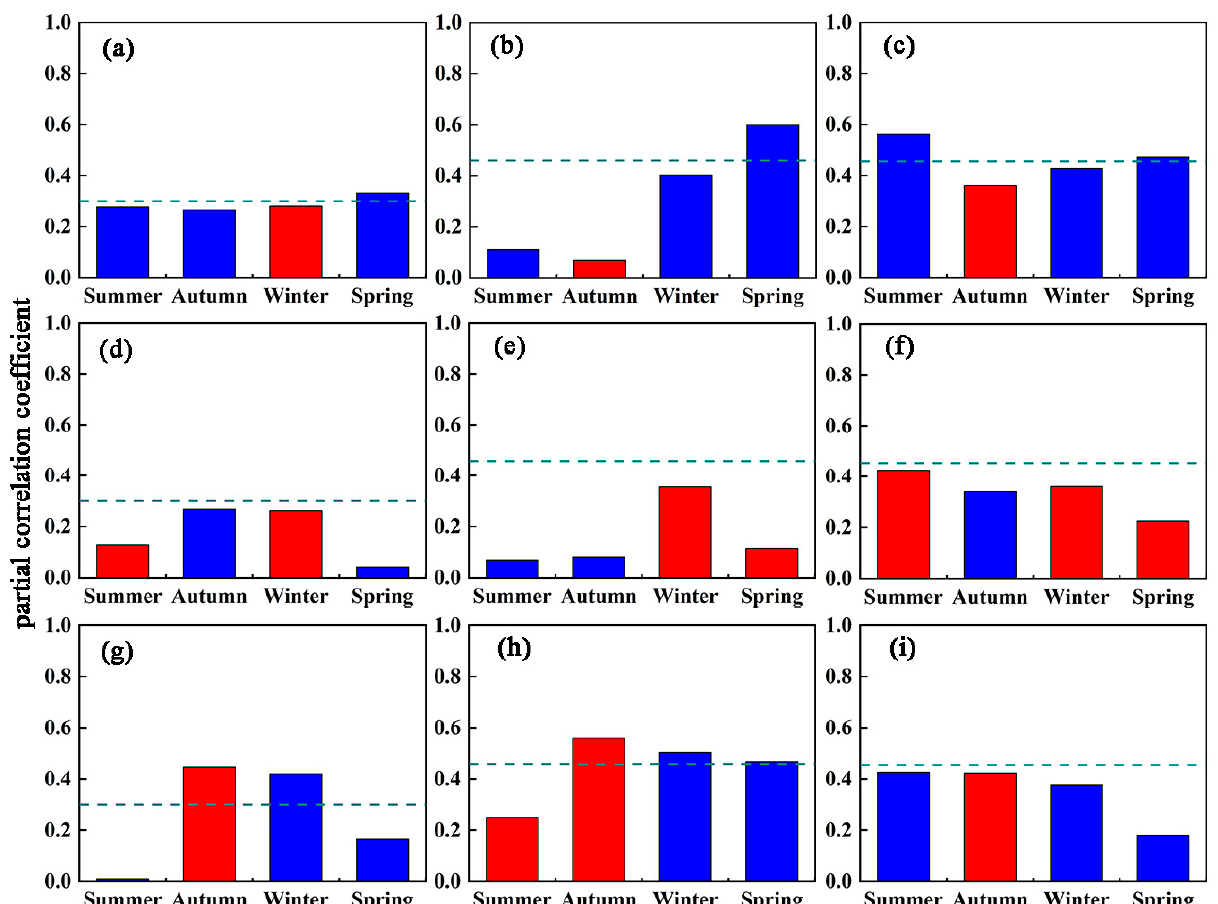
Figure 6. The response of deciduous broadleaf forest starting date of the growing season (DBF SOS) to changes in Tmax ( a – c ), Tmin ( d – f ) and precipitation ( g – i ) for the entire study period of 1982–2013 (( a , d , g ) at left), earlier rapid warming period to 1998 (( b , e , h ) in the middle), and short-term slowdown from 1998 (( c , f , i ) at right). Dashed lines indicate a significance level of 0.10; blue bars indicate negative correlations; red indicates positive correlations.